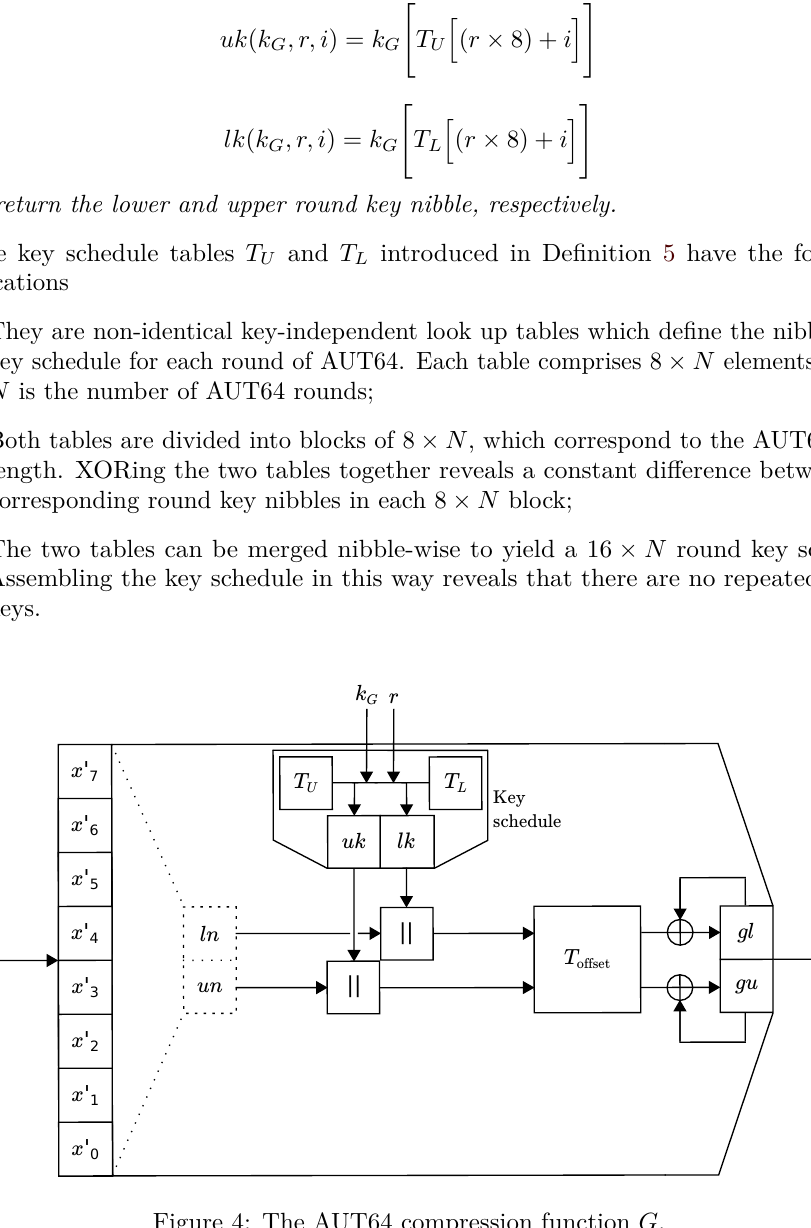
Figure 4: The AUT64 compression function G